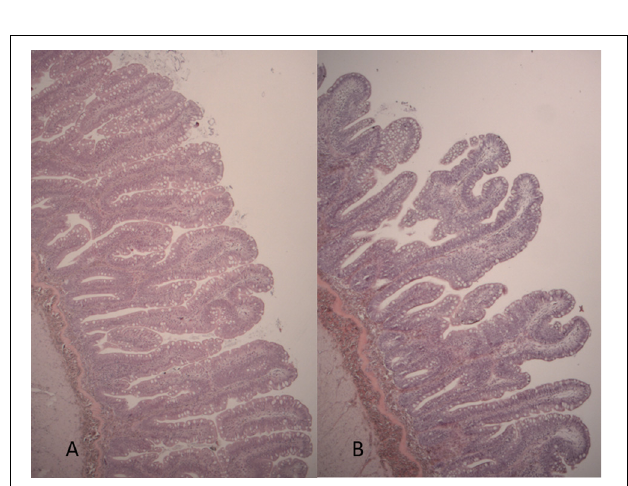
FIGURE 5 | Histological evaluation of intestinal tissues. Mid intestine. Histological sections of mid intestine in FO (A) and ScB (B) fish.